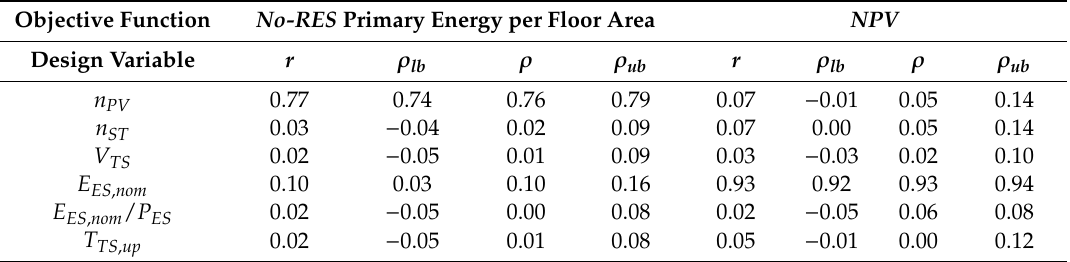
Table 5. Correlation coe ffi cients among the design variables and the objective